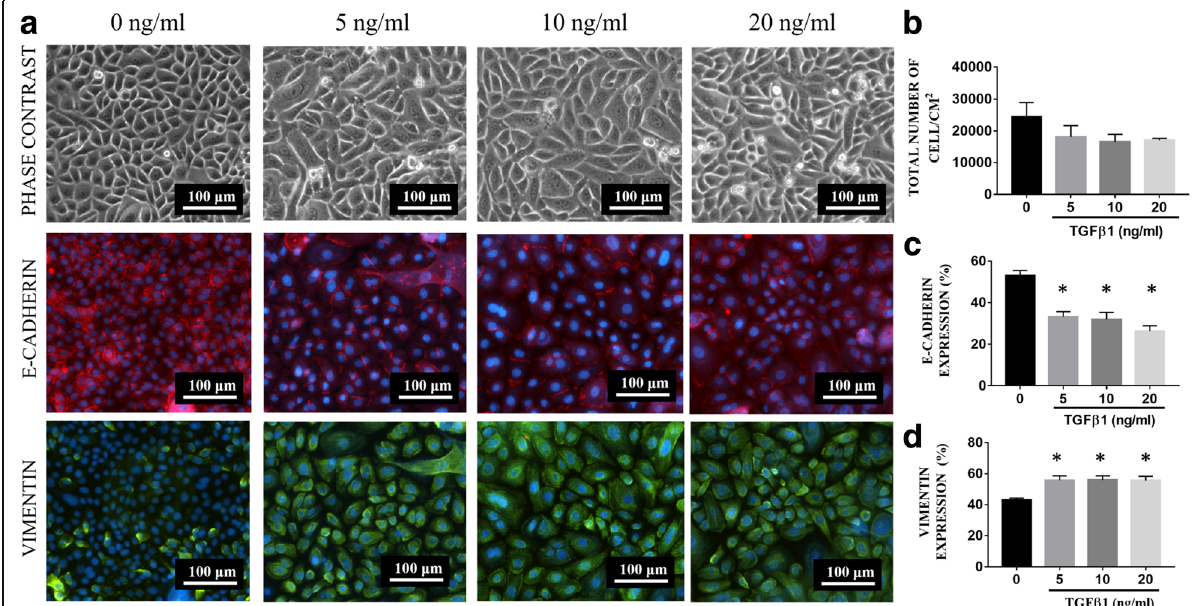
Fig. 2 a Phase-contrast and fluorescence microscope image of RECs treated with 0, 5, 10 and 20 ng/ml of TGF β 1. b Total number of cells after a 24-h treatment with 0, 5, 10 and 20 ng/ml. There is a reduction in the total number of cells after 24 h of treatment in all the experimental groups compared with the control (0 ng/ml). c Vimentin expression. d E-cadherin expression. * P < 0.05 indicates a significant difference compared